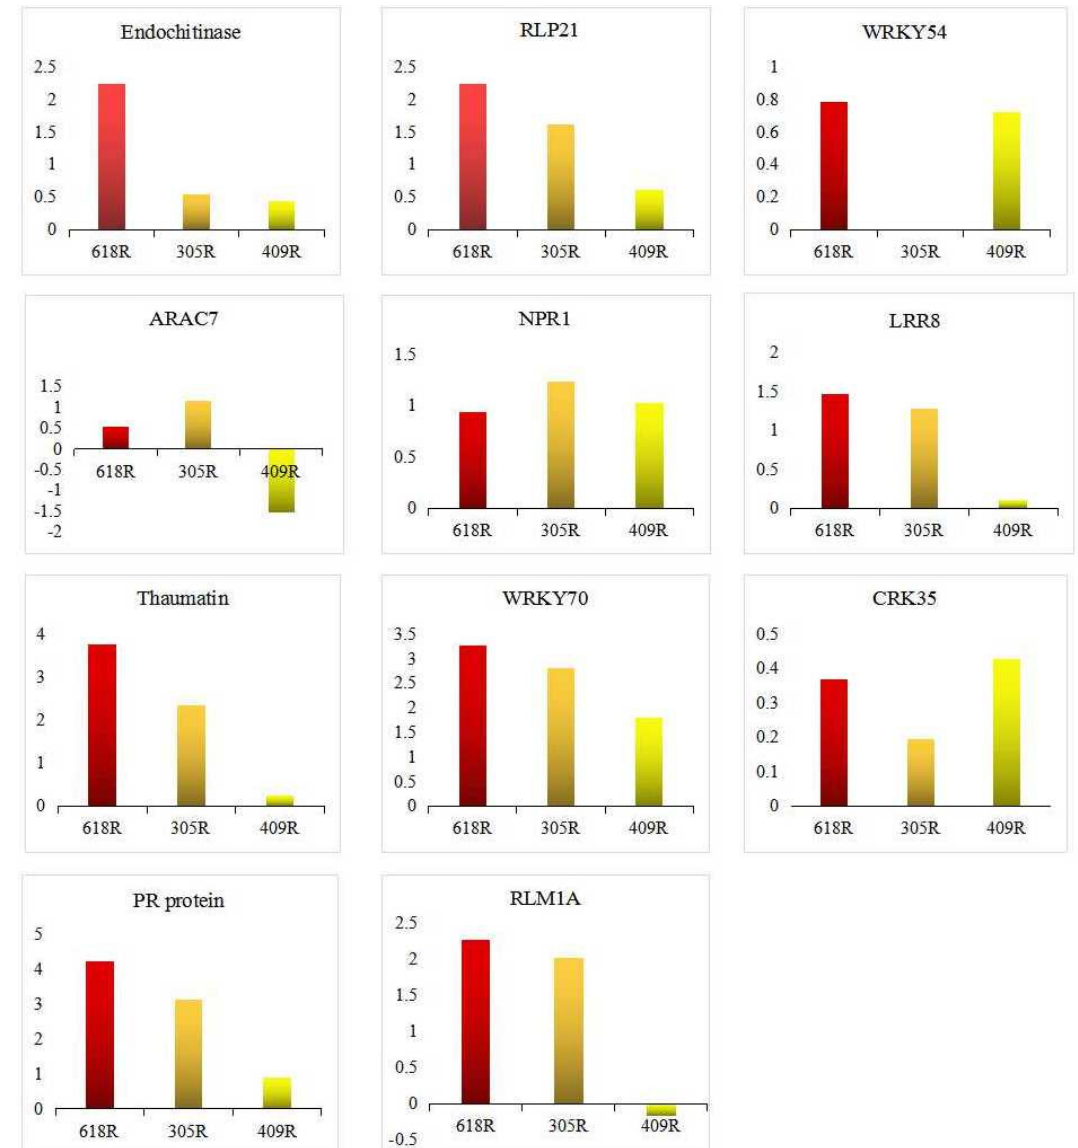
Figure 6. Validation of RNA sequencing (RNA-Seq) data by quantitative real time polymerase chain reaction qRT-PCR.